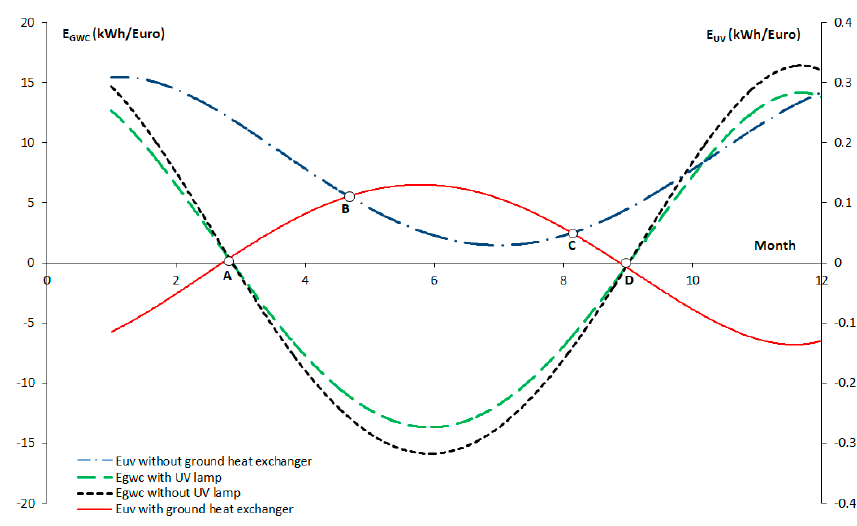
Figure 3. Electricity input necessary to produce thermal energy from the ground heat exchanger.